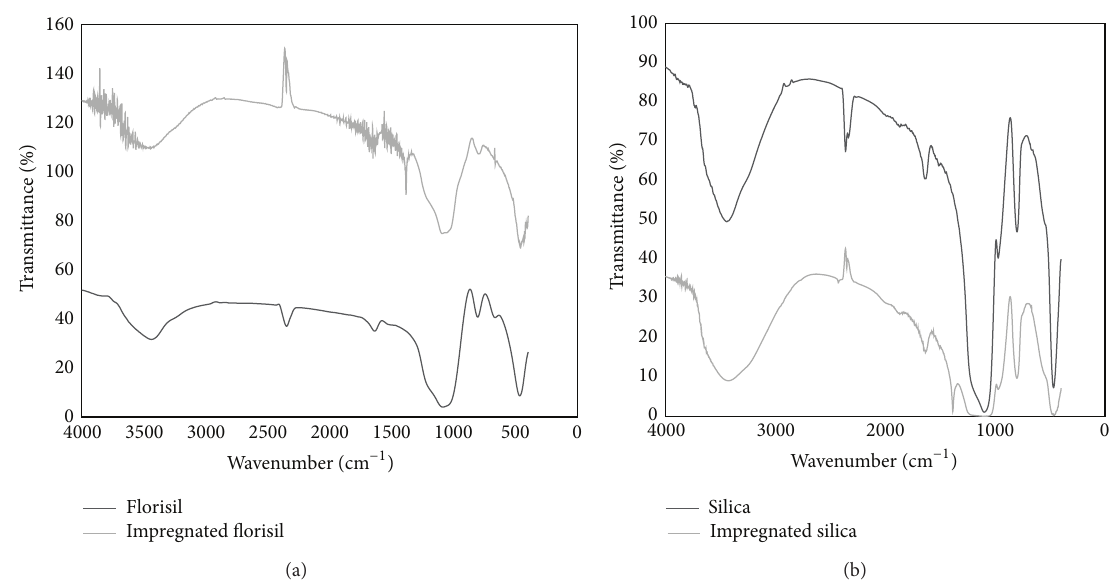
Figure 2: IR vibrational spectrum of studied adsorbents material. (a) Florisil. (b)